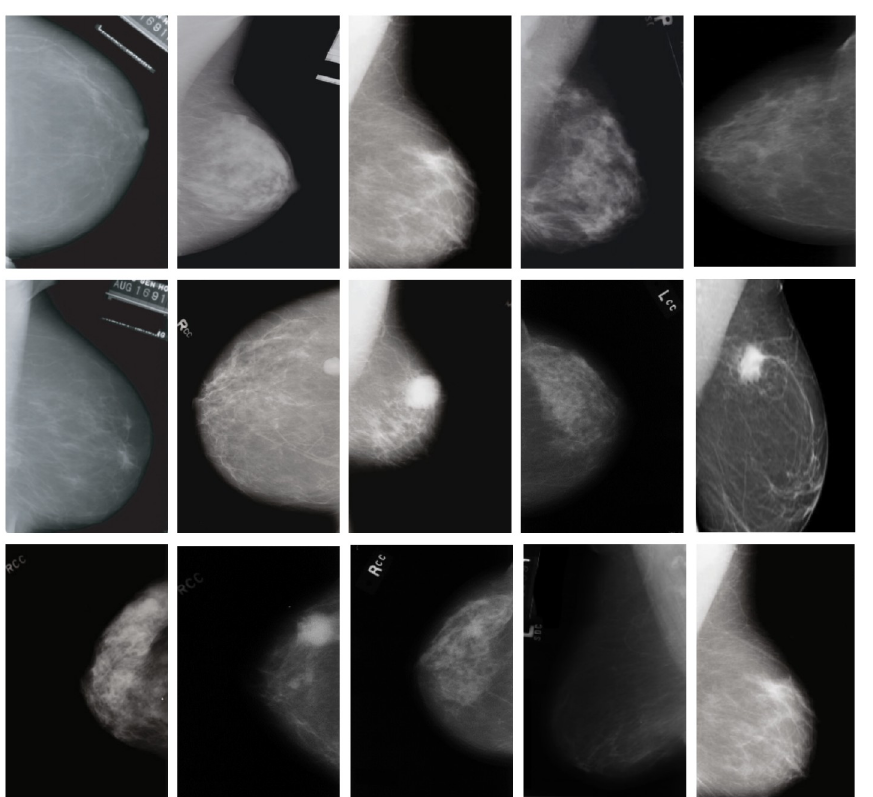
Fig 4. Some samples of mammogram